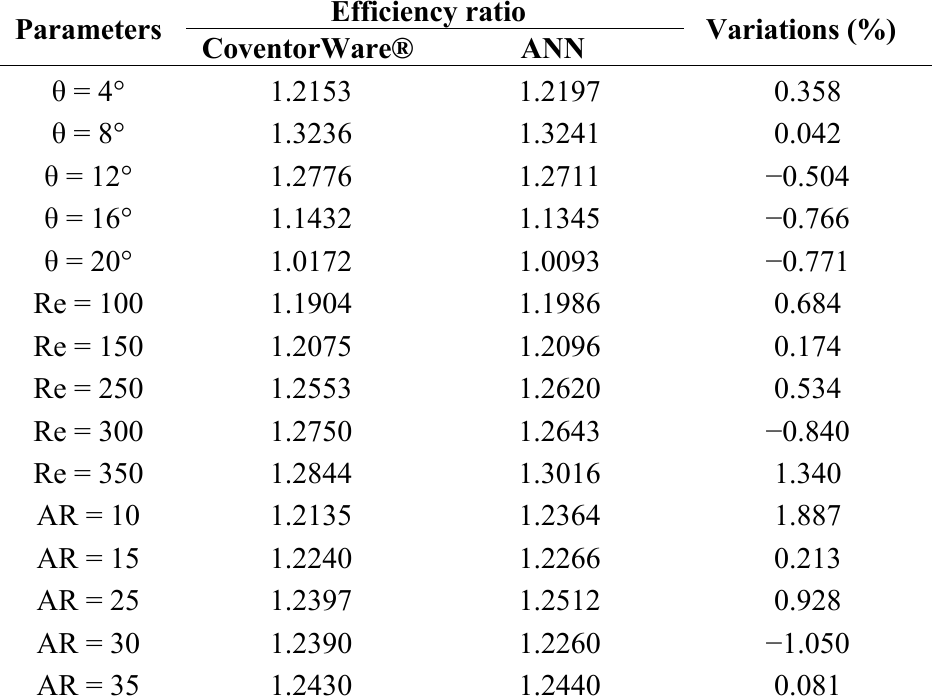
Table 6. Comparison of efficiency ratio results obtained from CoventorWare® simulations with ANN prediction for different parameters (Basic design values: θ = 5  ; Re = 200; AR =